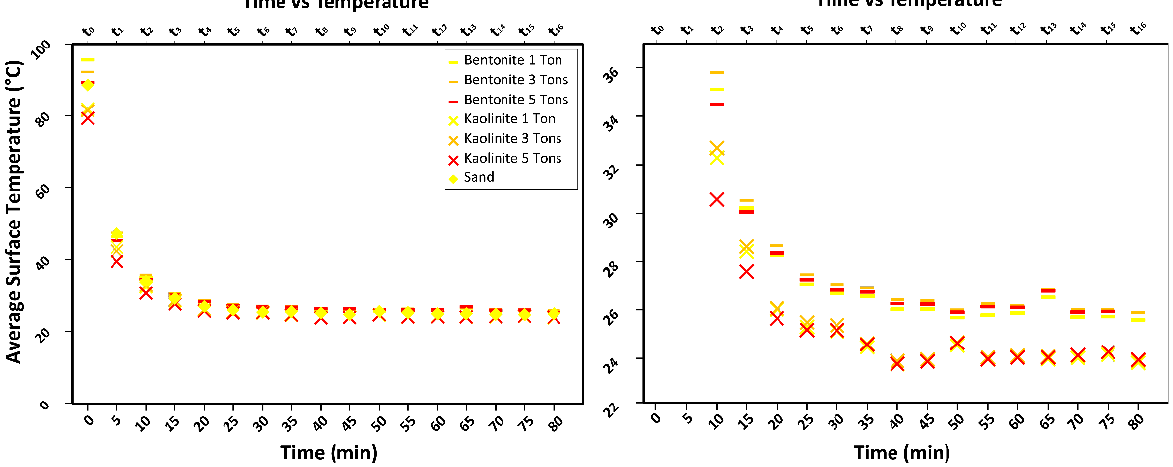
Figure 3. ( left ) Cooling phases computed from thermograms over the first 80 min after taking the samples out of the oven. The data series refer to bentonite and kaolin samples having different porosities (because they were compacted under different loads, i.e., 1, 3, or 5 tons). The response of sand samples (not compacted) was also investigated for comparison. ( right ) Detail of the cooling phases, zoomed in to better display the decay to the room temperature.